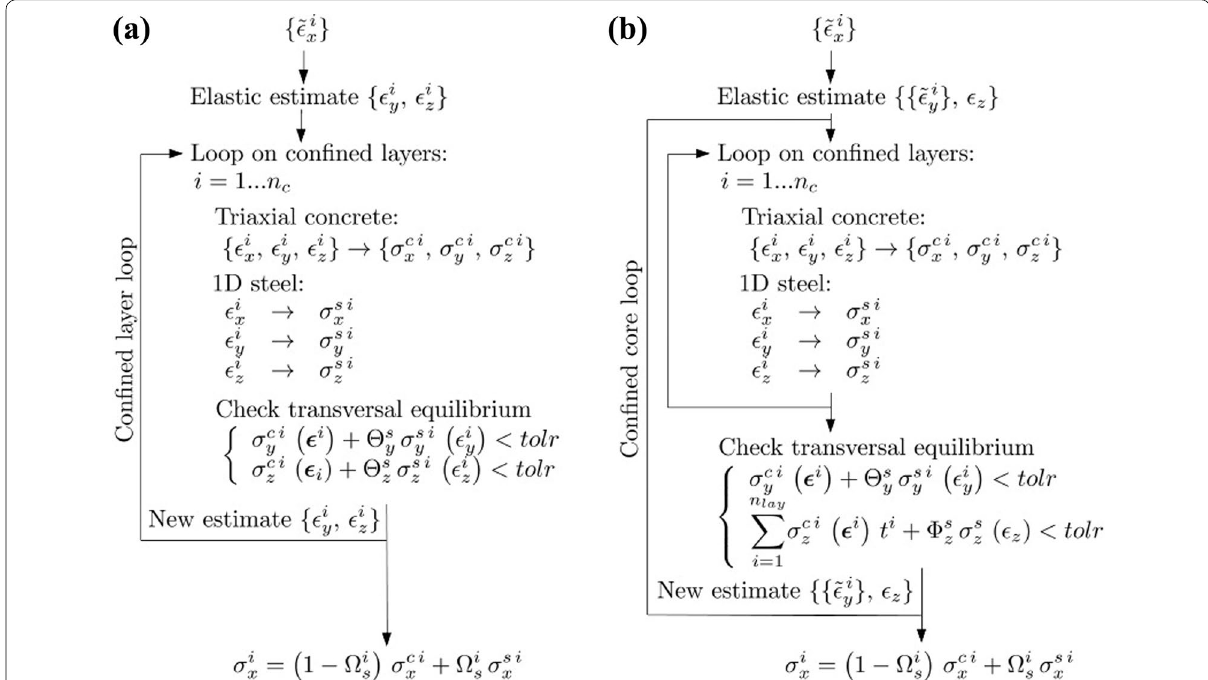
Fig. 4 Flowcharts of the solution algorithms used for a the black layerwise and b for the constant out-of-plane strain stirrup formulations with {˜ ǫ i x } and {˜ ǫ i y } the vector of axial and the in-plane transversal strains of the